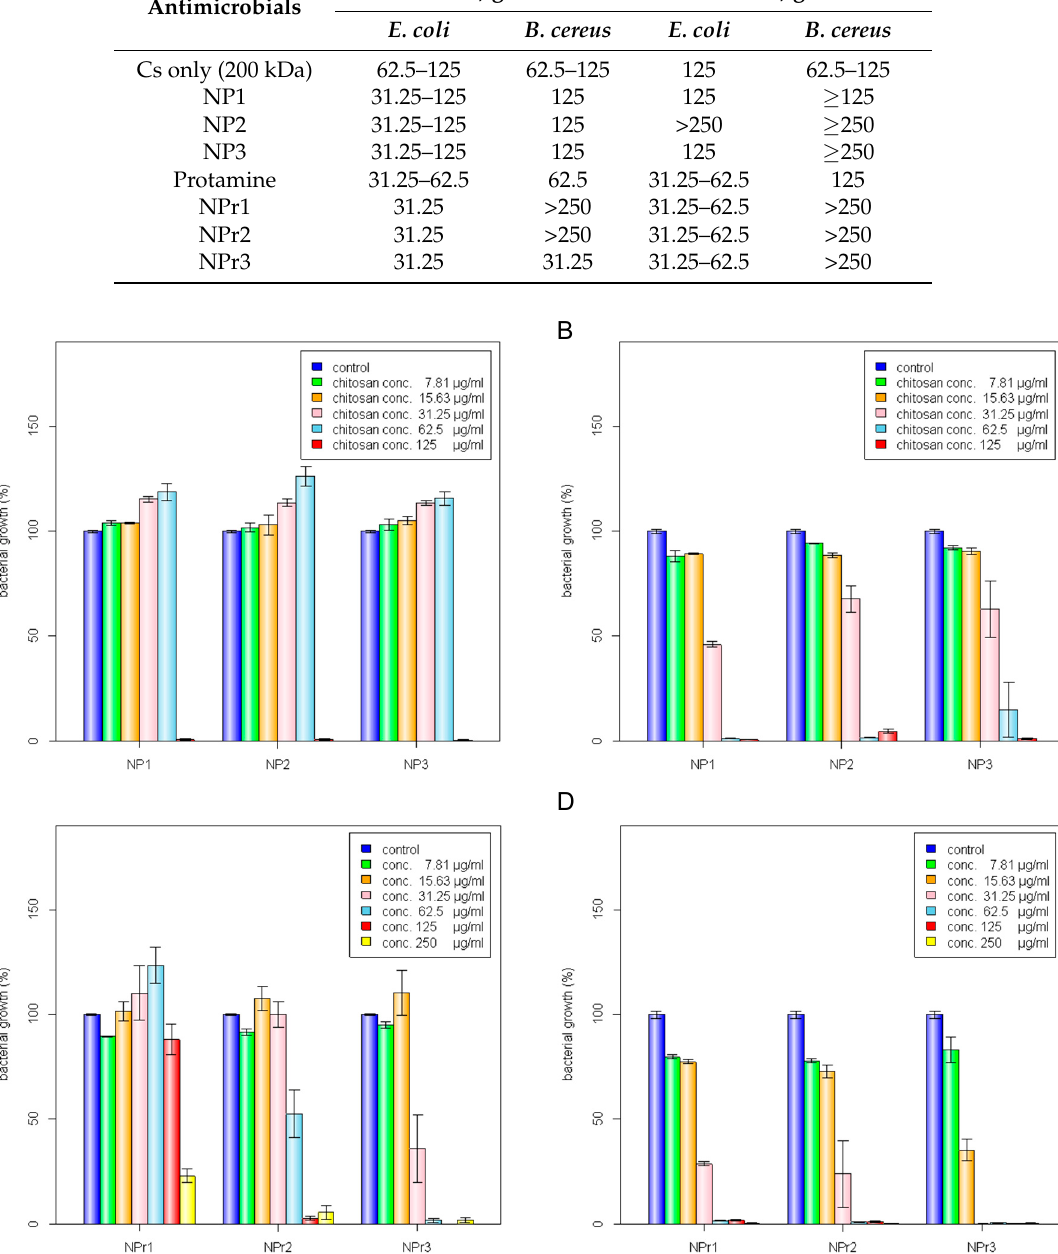
Table 3. Antimicrobial activity of chitosan (CS), chitosan nanoparticles (NP), protamine (Pr), and chitosan-protamine nanoparticles (NPr) against E. coli and B. cereus .